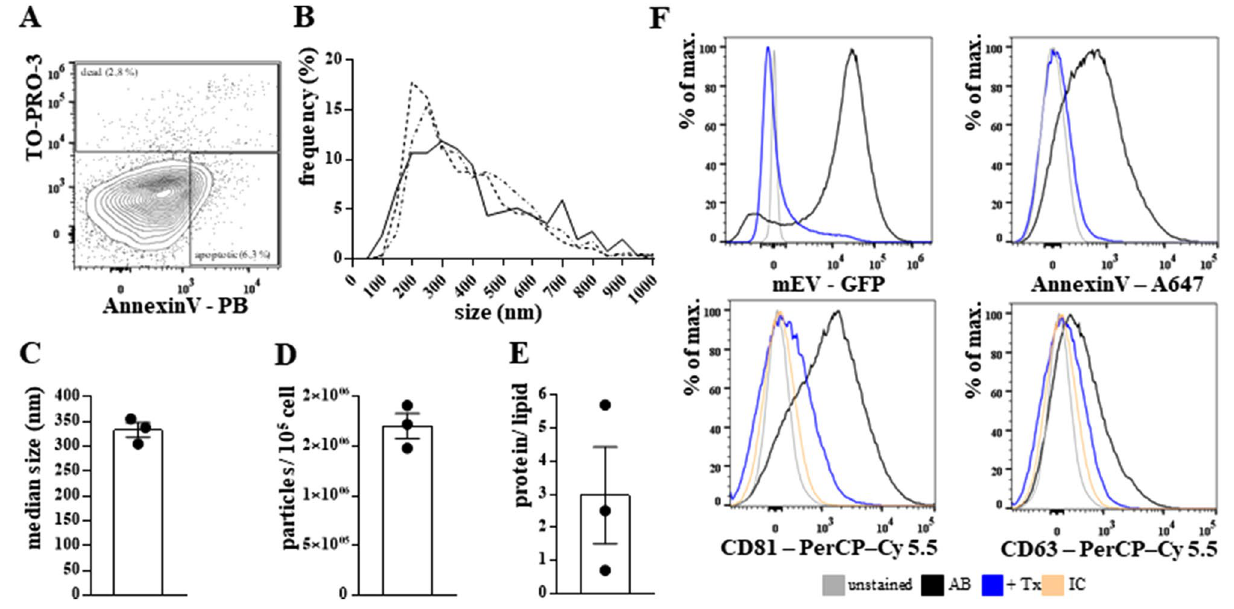
Figure 1. Characterization of HEK293T-palmGFP-derived free mEVs. The viability of the cells was analyzed by flow cytometry ( A ). We determined the size distribution ( B ), median size ( C ), and particle concentration ( D ) of mEVs by nanoparticle tracking analysis (NTA). We quantified the vesicles based on their protein and lipid content ( E ). The presence of GFP, externalized phosphatidyl-serine (stained with AnnexinV), CD81 and CD63 were detected by flow cytometry ( F ). (AB: antigen-specific staining with antibody, Tx: Triton X-100, IC: isotype control) (Figure was prepared using GraphPad Prism 7.00 for Windows, GraphPad Software, San Diego, California USA, http:// www. graph pad.